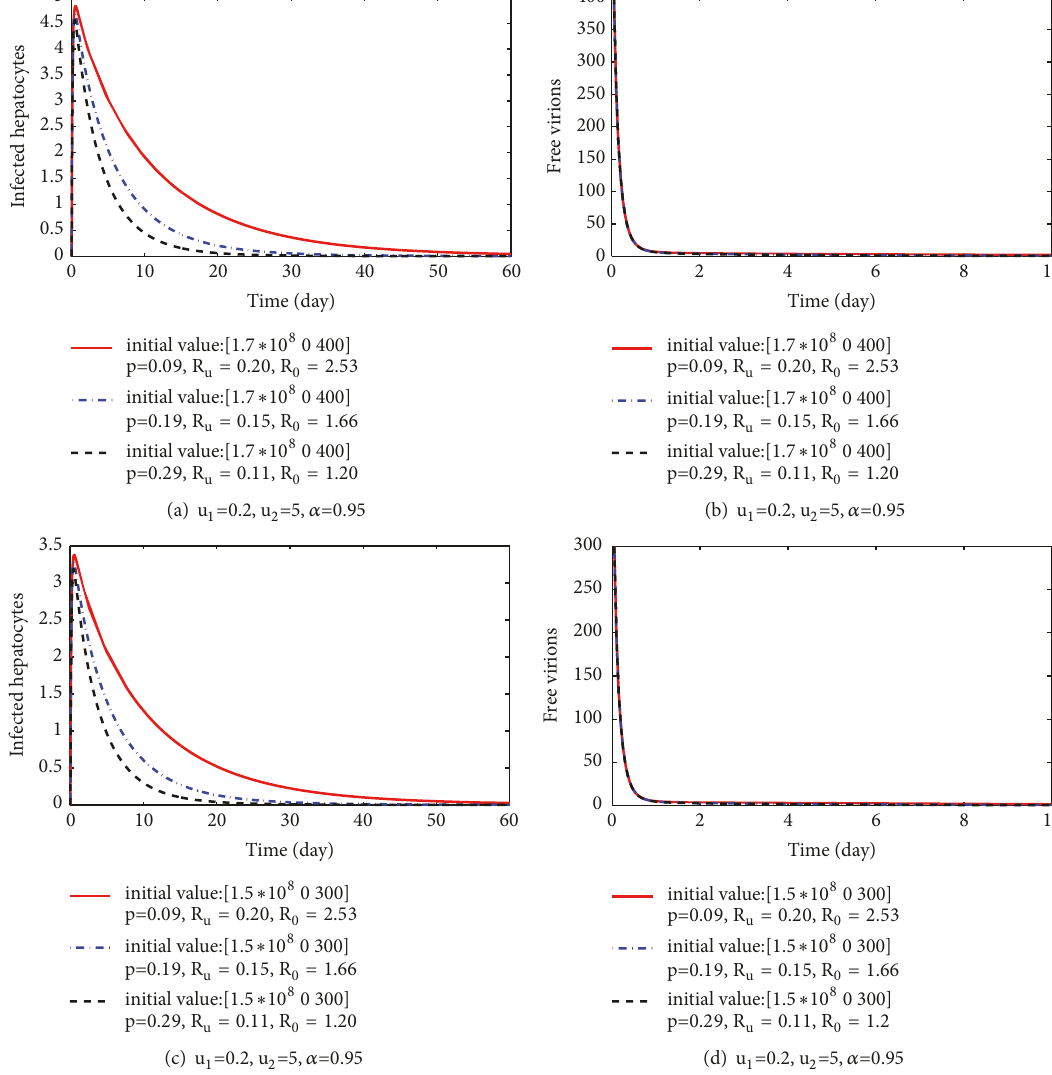
Figure 5: In this case, both IFN and LAM are used to control HBV. For different values of 𝑝 , we can choose suitable values of 𝑢 1 and 𝑢 2 such that 𝑅 𝑢 < 1 < 𝑅 0 , and these figures show that the disease-free equilibrium 𝐸 0 𝑢 = (Π/𝛿, 0, 0) = (1.667 × 10 8 ,0,0) is asymptotically stable. The initial conditions of (a) and (b) are as follows: [ 1.7 × 10 8 0 400]; the initial conditions of (c) and (d) are as follows: [ 1.5 × 10 8 0